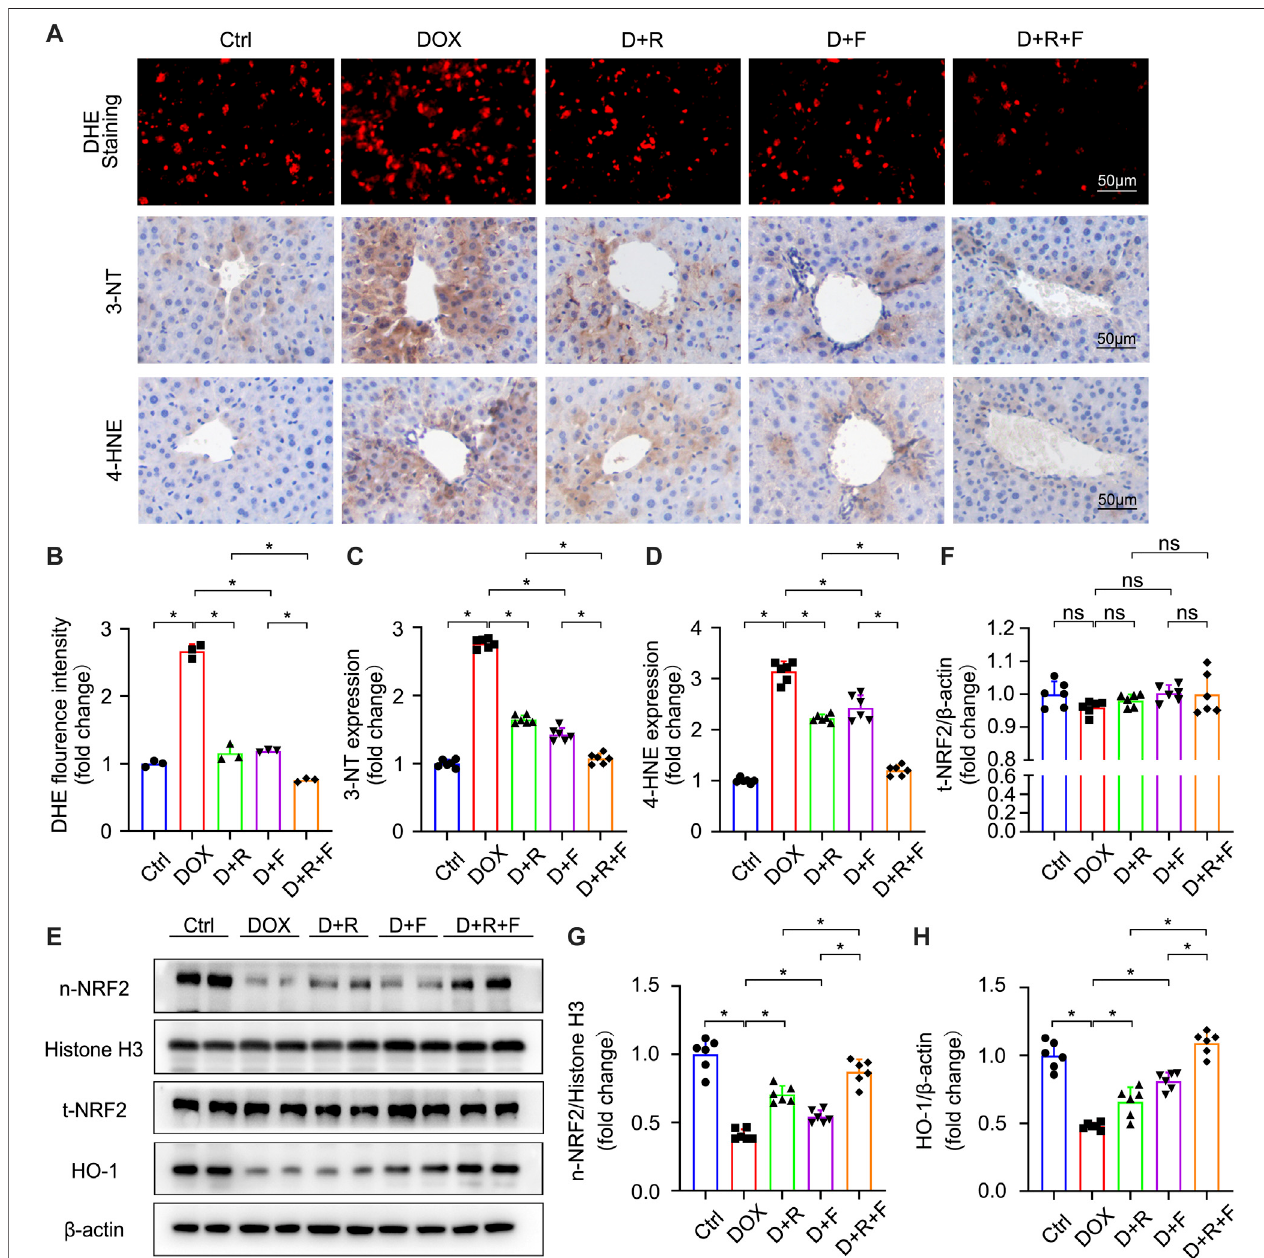
FIGURE 2 | RES and FGF1 co-treatment mitigated DOX-induced oxidative stress in the mouse liver, with increases in NRF2 activity and HO-1 expression observed. (A,B) Representative fl uorescence microscopy images of DHE-stained frozen liver tissue slices and quantitative analysis of the fl uorescent intensity of DHE staining after the indicated treatments ( n = 3). (A,C,D) Representative IHC staining images of (C) 3-NT and (D) 4-HNE in liver tissues, and quanti fi cation of their expression ( n = 6). (E – H) t-NRF2, n-NRF2 and HO-1 protein expression. β -actin or histone H3 was used as the loading control in all western blot analysis ( n = 6). Data are expressed as mean ± SD. * p <